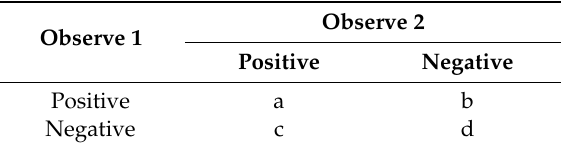
Table 2. Symbol to calculate the kappa